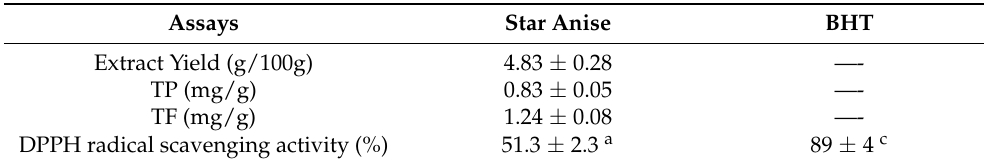
Table 1. Aqueous extract yield, total phenolic content and total flavonoid contents and DPPH radical scavenging activity of star anise tea. Assays Star Anise BHT Extract Yield (g/100g) 4.83 ± 0.28 —- TP (mg/g) 0.83 ± 0.05 —- TF (mg/g) 1.24 ± 0.08 —- DPPH radical scavenging activity (%) 51.3 ± 2.3 a 89 ± 4